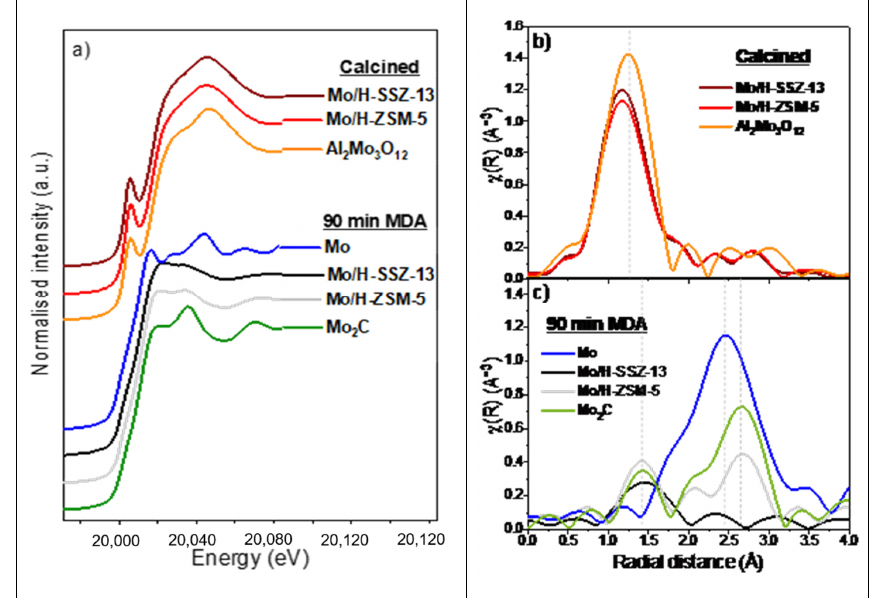
Figure 3. Mo K-edge XAS spectra showing: ( a ) XANES of Mo / zeolites after calcination and after 90 min of methane dehydroaromatisation (MDA) reaction (700 ◦ C, 50% CH 4 / Ar, gas hour space velocity (GHSV) = 300 h − 1 ) together with Al 2 (MoO 4 ) 3 , Mo, and Mo 2 C references; ( b ) FT-EXAFS of calcined Mo / zeolite compared to Al 2 (MoO 4 ) 3 ; and ( c ) FT-EXAFS of Mo / zeolites after 90 min of MDA compared to Mo 2 C and metallic Mo. The maxima in the FT-EXAFS of the reference spectra is indicated by vertical dashed